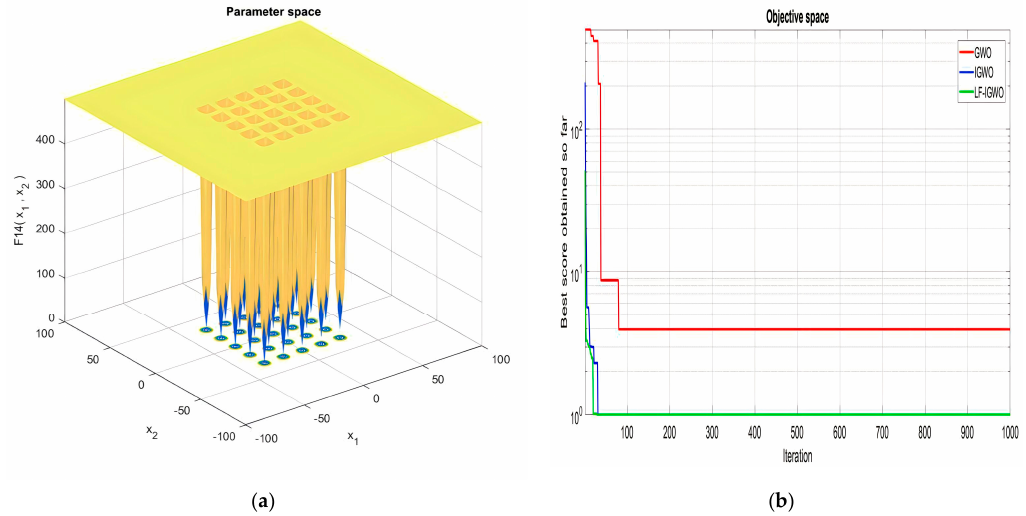
Figure 16. ( a ) Search space for fixed dimensional function F14 ( b ) Comparison of convergence curve for F14.